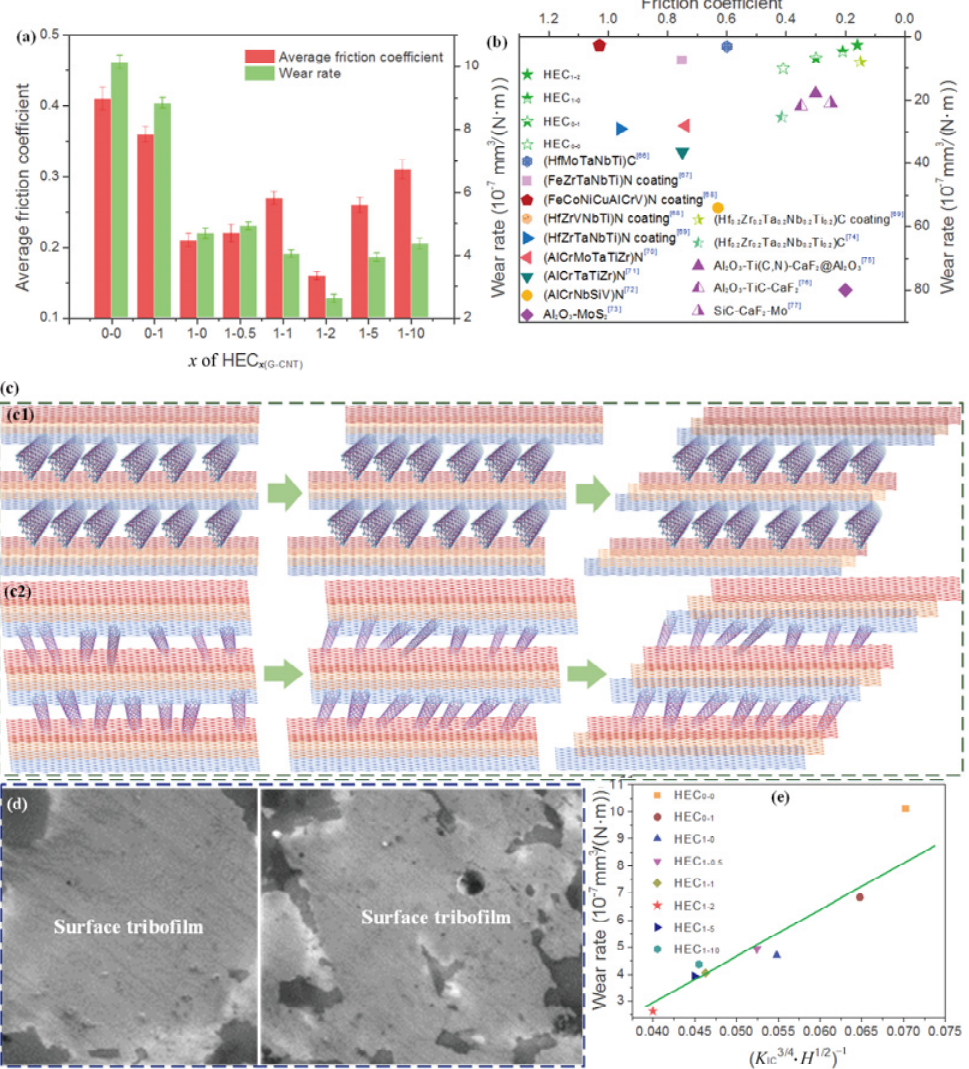
Fig. 5 (a) Friction coefficients and wear rate evolutions of HEC with various additives, (b) comparison of friction coefficients and wear rates in this study and those reported for other HEC, HEC coatings, and ceramic with lubricating phases [66–77], (c) lubricating mechanism of 3D G–CNT for (c1) CNT adsorbed horizontally to G surface and (c2) CNT adsorbed perpendicularly to G surface, (d) SEM images of tribolayer formation, and (e) plot of w vs. ( 3/4 1/2